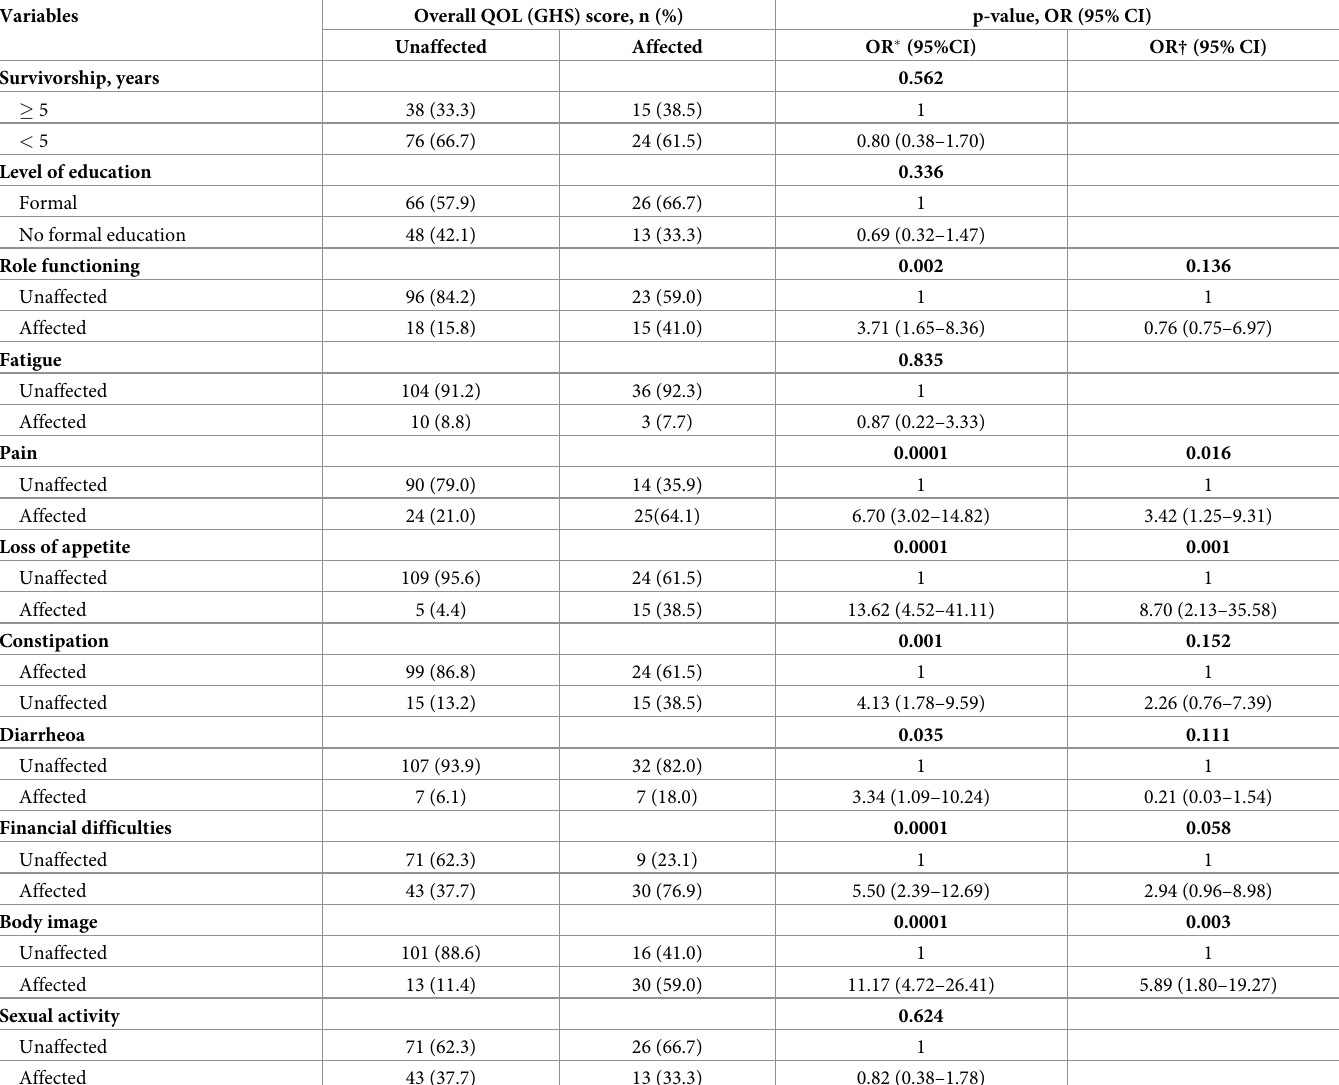
Table 6. Predictors of Overall QoL of the cervical cancer survivors after